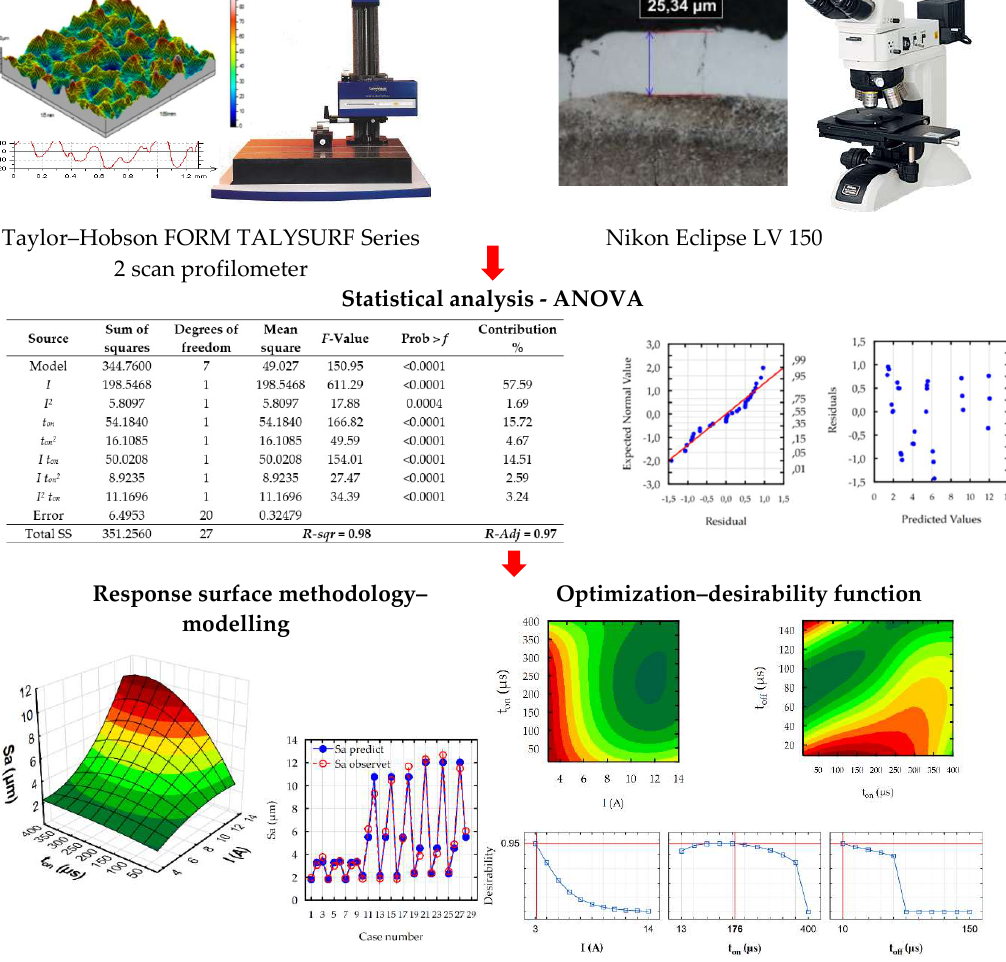
Figure 1. The schematic diagram of the experimental set-up.